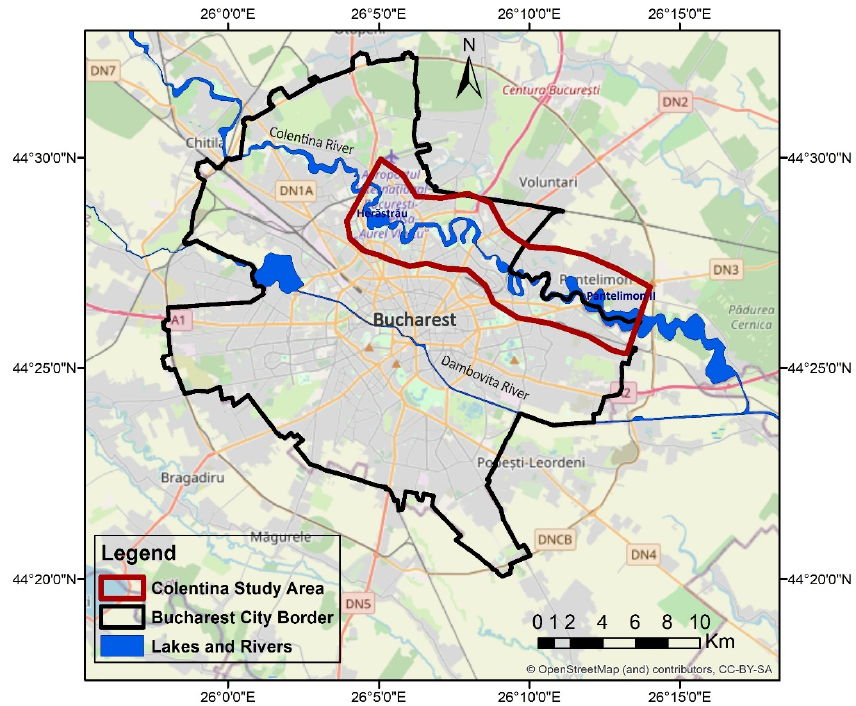
Figure 3. Colentina River corridor study area. Map generated in Esri ® ArcMap™ 10.3. Base map source: OpenStreetMap. Source: elaborated by the authors. Short Overview of the Processing and Analysis of Satellite Data for Identification and an Outline of the Main Subsidence Triggering Factors